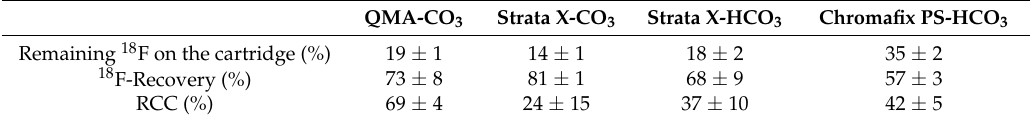
Table 2. Dependency of 18 F-recovery and 18 F-incorporation yields on the type of anion exchange cartridge. Conditions: [ 18 F]Fluoride (~50 MBq) was eluted from the respective anion exchange cartridge with a solution of Et 4 NOTf (3.1 mg, 11 µ mol) in n BuOH (300 µ L) (see legend of Table 1). A solution of PhSnMe 3 (14.5 mg, 60 µ mol) and Cu(py) 4 (OTf) 2 (20.3 mg, 30 µ mol) in DMA (700 µ L) was added, the reaction mixture was heated at 100 ◦ C for 10 min under air atmosphere, diluted with H 2 O (1–4 mL) and analyzed by HPLC. All experiments were carried out in triplicate. QMA-CO 3 Strata X-CO 3 Strata X-HCO 3 Chromafix PS-HCO